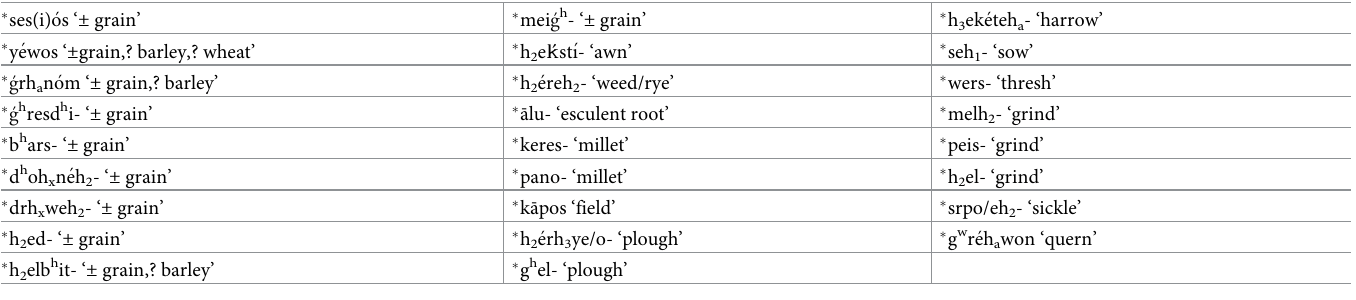
Table 1. Proposed Indo-European agricultural terms found in at least one European and one Asian language.